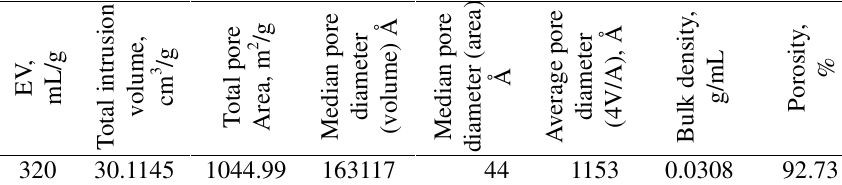
Table 1. Structural parameter of expanded